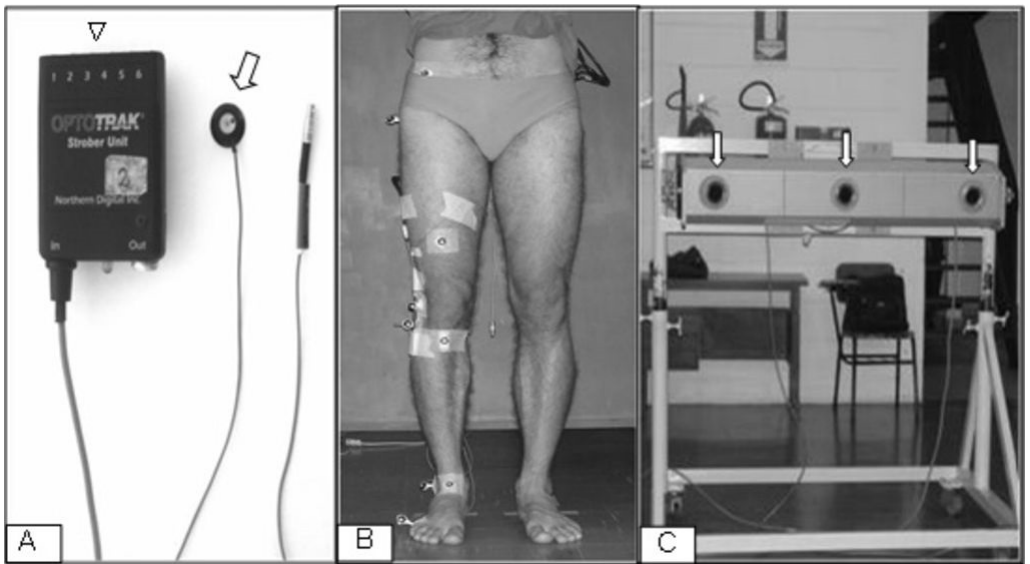
Figure 2. Optoelectronic system (Optotrak): A = active marker (arrow) and connection support (arrow head); B = positioning of the markers; C = camera